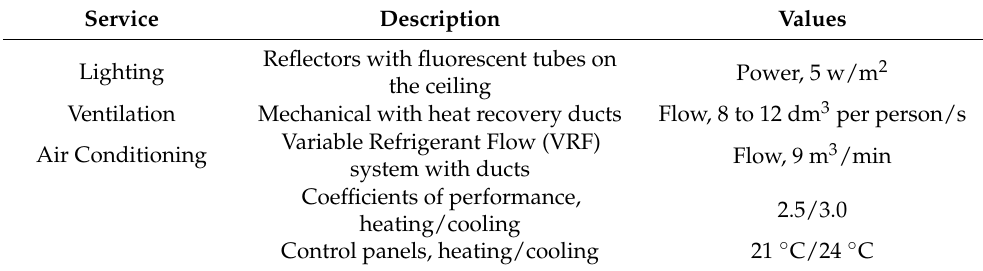
Table 3. Services are available in the rooms under